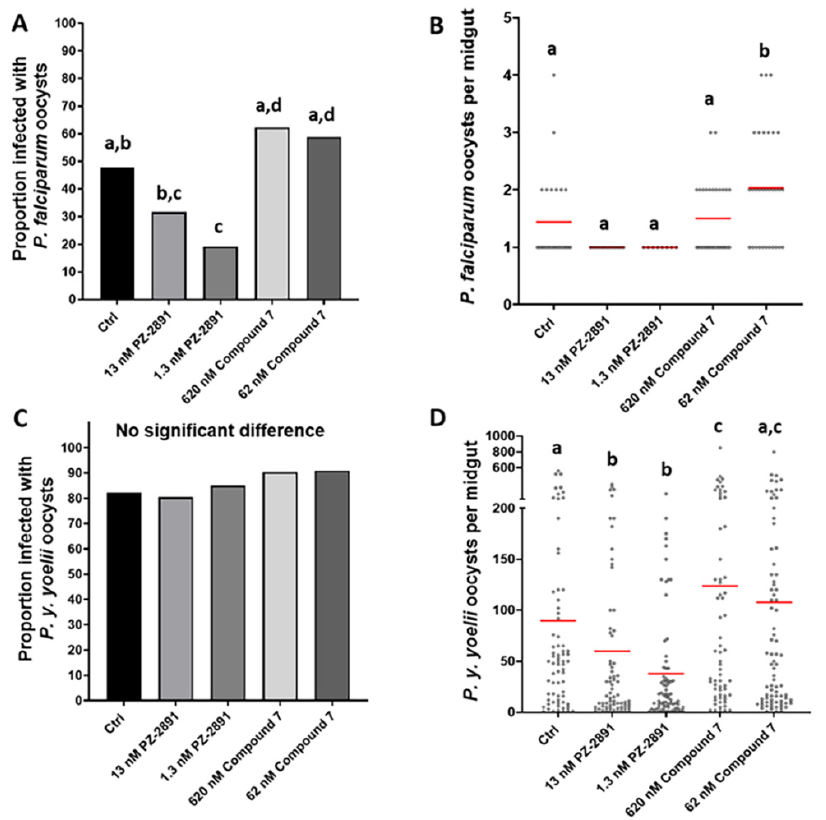
Figure 6. PZ-2891 and compound 7 decreased and increased, respectively, P. y. yoelii 17XNL and P. falciparum infection of A. stephensi . Graphs A and C represent infection prevalence for P. yoelii and P. falciparum, respectively, while B and D show infection intensity. Prevalence data (A,C) were analyzed by Chi-square and Fisher’s exact tests and infection intensity data (B,D) were analyzed by one-way ANOVA and Tukey’s post hoc test. Different lower case letters above data columns indicate groups that are significantly different by Chi-square (graphs A,C) or ANOVA and Tukey’s (graphs B,D) at the α = 0.05 level of significance (i.e., data indicated as “a” are significantly different from data indicated as “b” within a single graph). ( A ). P. falciparum infection prevalence. Specific p -values for significant differences are as follows: Control (Ctrl) vs. 1.3 nM PZ-2891 p = 0.0073; 13 nM PZ-2891 vs. 620 nM compound 7 p = 0.0009; 13 nM PZ-2891 vs. 62 nM compound 7 p = 0.0022; 1.3 nM PZ-2891 vs. 620 nM compound 7 p < 0.0001; 1.3 nM PZ-2891 vs. 62 nM compound 7 p = 0.0001. Two biological replicates were performed with unique cohorts of mosquitoes (n = 28– 30 mosquitoes per control and treatment groups). ( B ). P. falciparum infection intensity. Numbers of oocysts per midgut of individual female A. stephensi mosquitoes infected with P. falciparum are represented by black circles . Red bars represent mean oocysts/midgut. Specific p -values for signifi- cant differences are as follows: Ctrl vs. 62 nM compound 7 p = 0.0266; 13 nM PZ-2891 vs. 62 nM compound 7 p = 0.0004; 1.3 nM PZ-2891 vs. 62 nM compound 7 p = 0.0051; 620 nM compound 7 vs. 62 nM compound 7 p = 0.0424. ( C ). P. yoelii prevalence. No significant differences were observed among groups, likely due to the high infection prevalence overall. Three biological replicates were performed with unique cohorts of mosquitoes (n = 70–88 mosquitoes per group). ( D ). P. yoelii in- fection intensity. Numbers of oocysts per midgut of female A. stephensi mosquitoes infected with P. yoelii. Red bars represent mean oocysts/midgut. Specific p -values for significant differences are as follows: Ctrl vs. 13 nM PZ-2891 p = 0.0164; Ctrl vs. 1.3 nM PZ-2891 p = 0.0003; Ctrl vs. 620 nM compound 7 p = 0.055; 13 nM PZ-2891 vs. 620 nM compound 7 p = 0.0009; 13 nM PZ-2891 vs. 62 nM compound 7 p = 0.0081; 1.3 nM PZ-2891 vs. 620 nM compound 7 p < 0.0001; 1.3 nM PZ-2891 vs. 62 nM compound 7 p < 0.0001.